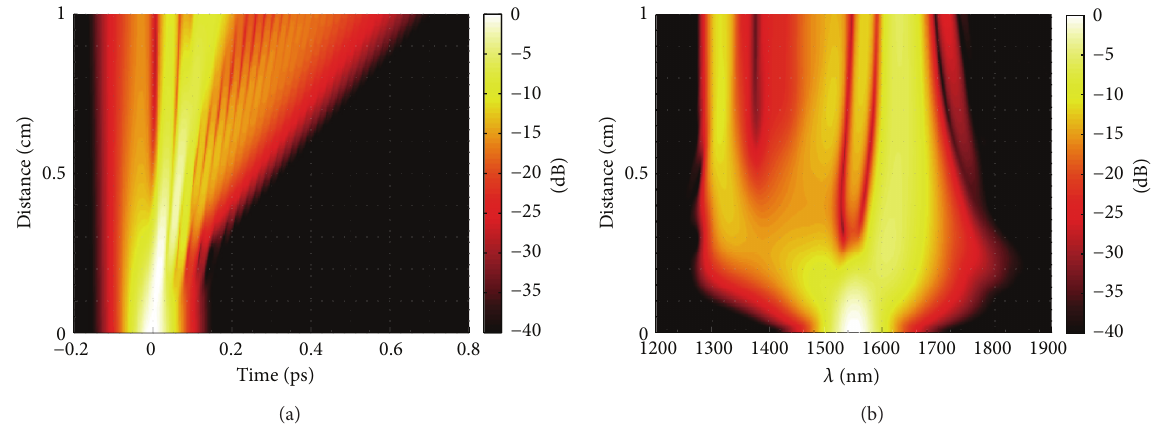
Figure 4: Results from numerical simulations showing (a) temporal and (b) spectral evolution for 1cm long silicon waveguide. The input soliton is 50 fs (FWHM), 25 W peak power hyperbolic secant soliton with order 𝑁 = 3